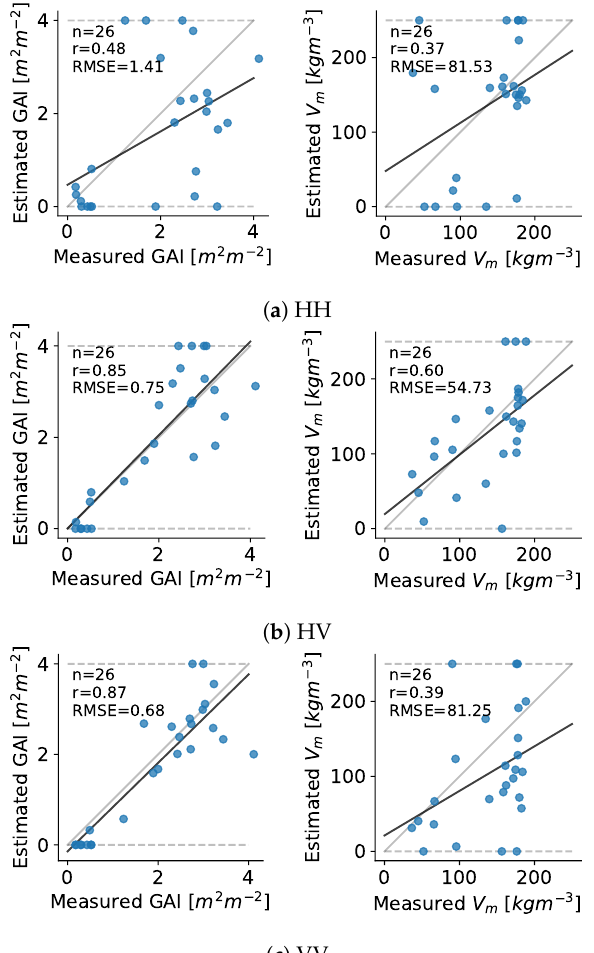
Figure 11. Results from the LOOCV for the retrieval of either maize GAI or volumetric surface soil moisture, V m , using the algebraic inversion of the WCM with L-band data in ( a ) horizontal co-polarization, HH; ( b ) cross-polarization, HV; ( c ) vertical co-polarization,